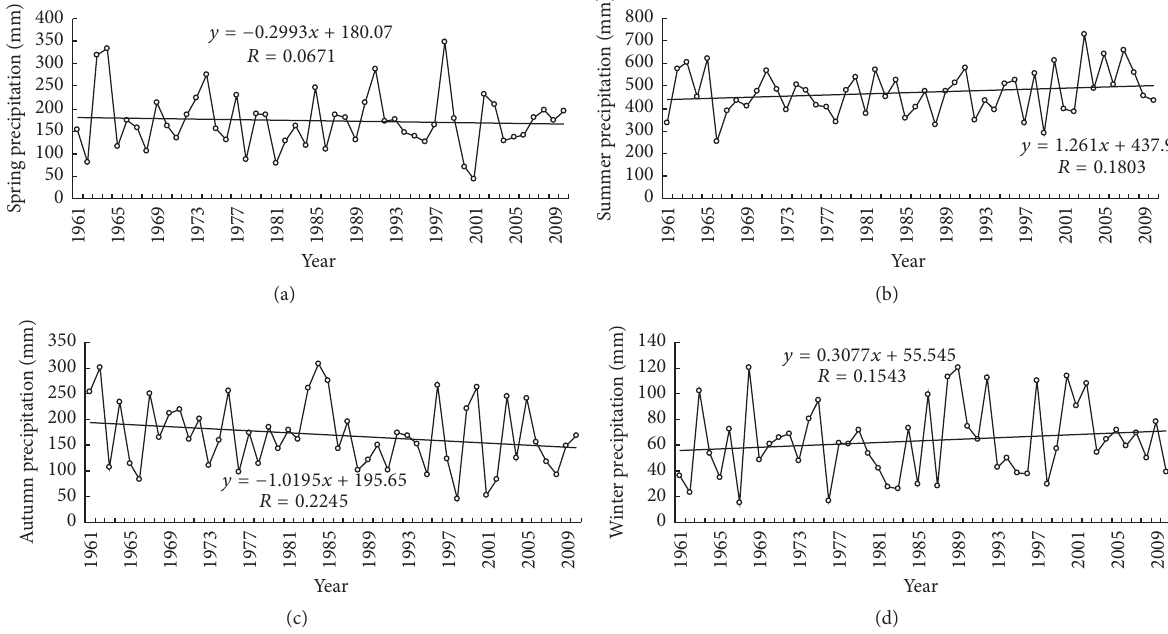
Figure 6: Temporal changes of spring precipitation (a), summer precipitation (b), autumn precipitation (c), and winter precipitation in the Huaihe River